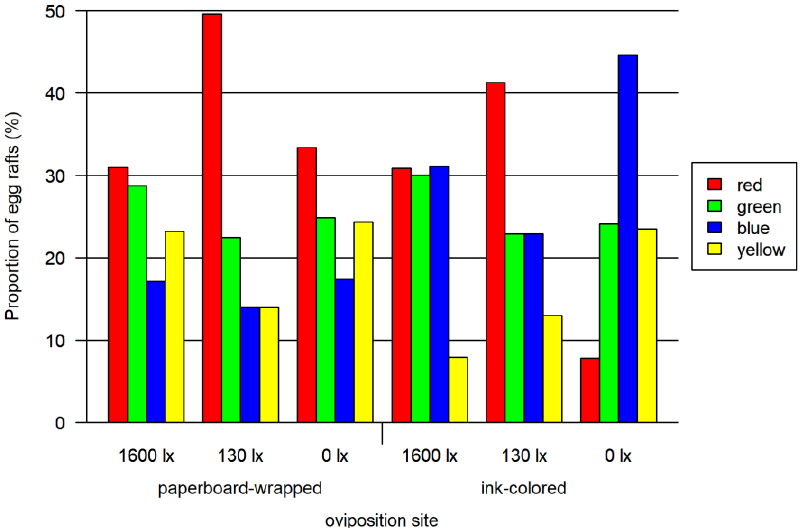
Figure 2. Results of paperboard-wrapped oviposition site bioassay and ink-colored oviposition site bioassay. Both tested at three light intensities. The 1600 lx light intensity was the maximal light intensity of a 16:8 h light cycle (Light:Dark; separated by one hour crepuscular periods; daylight 1600